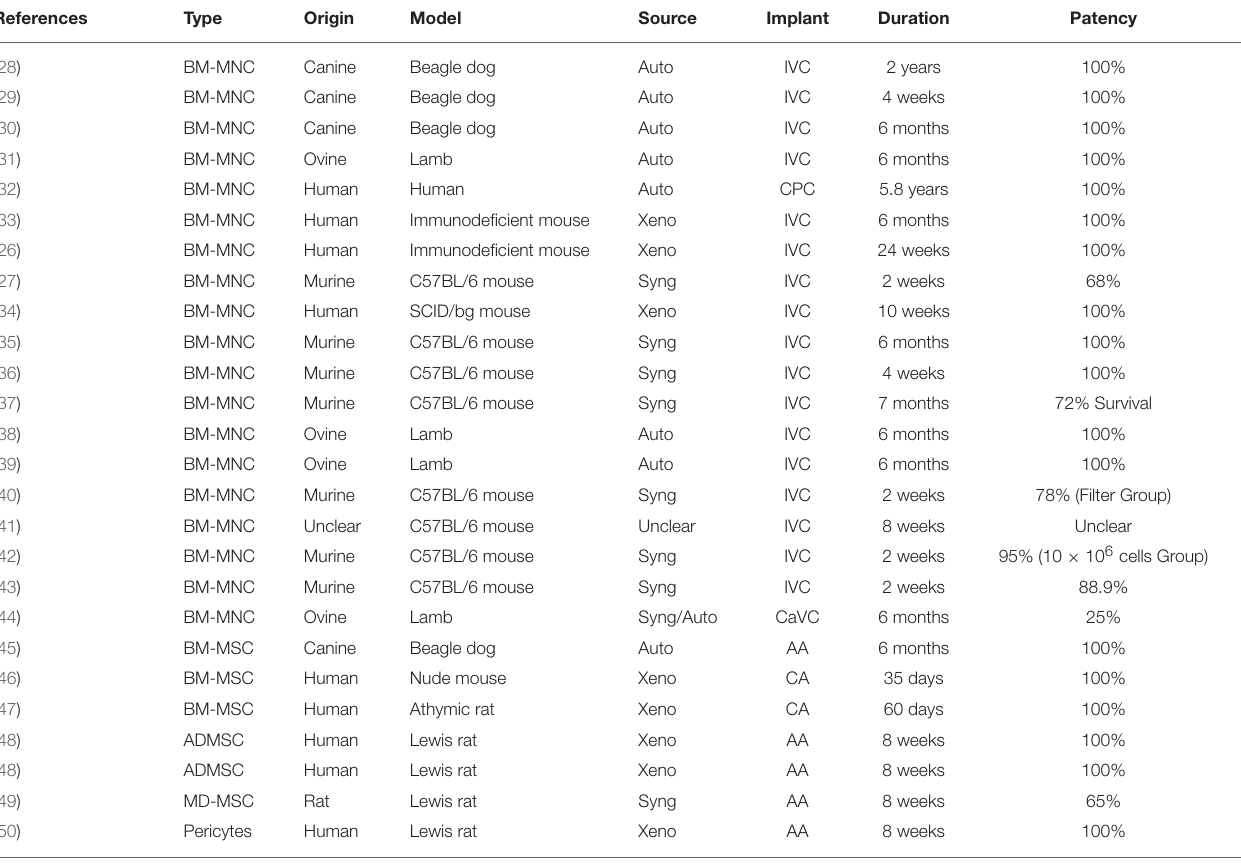
TABLE 1 | Studies that have implanted scaffolds seeded with stem cells as vascular